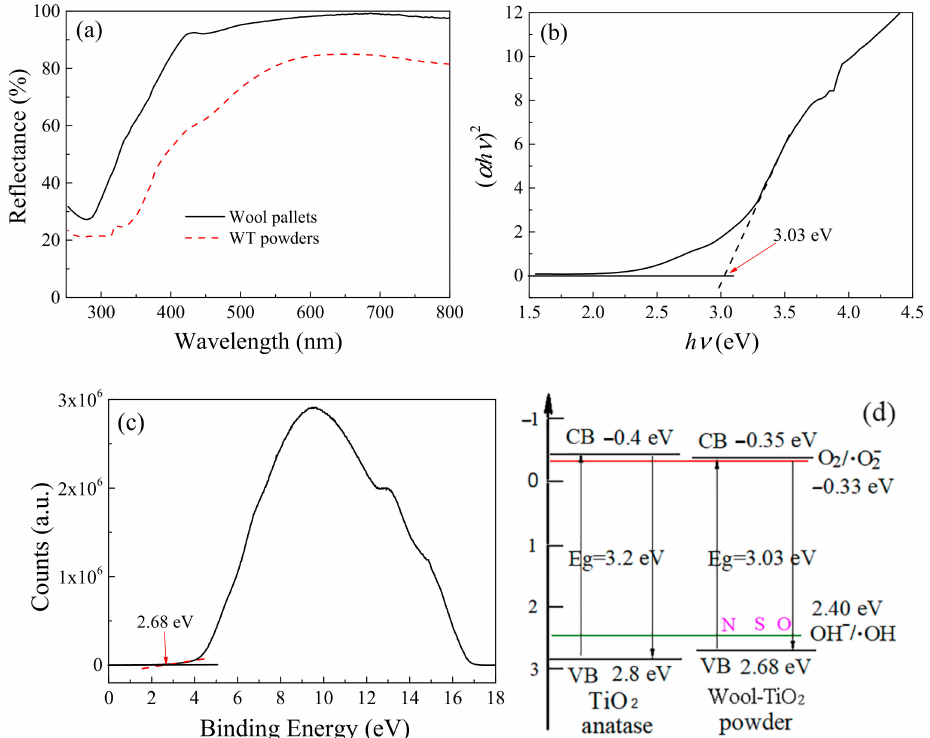
Figure 4. ( a ) Diffuse reflectance spectra of wool pallets before and after loading TiO 2 , and ( b ) the corresponding plot of ( α hv ) 2 ~ hv ; ( c ) the UPS spectrum, and ( d ) schematic diagram of energy band-gap of the WT powders.